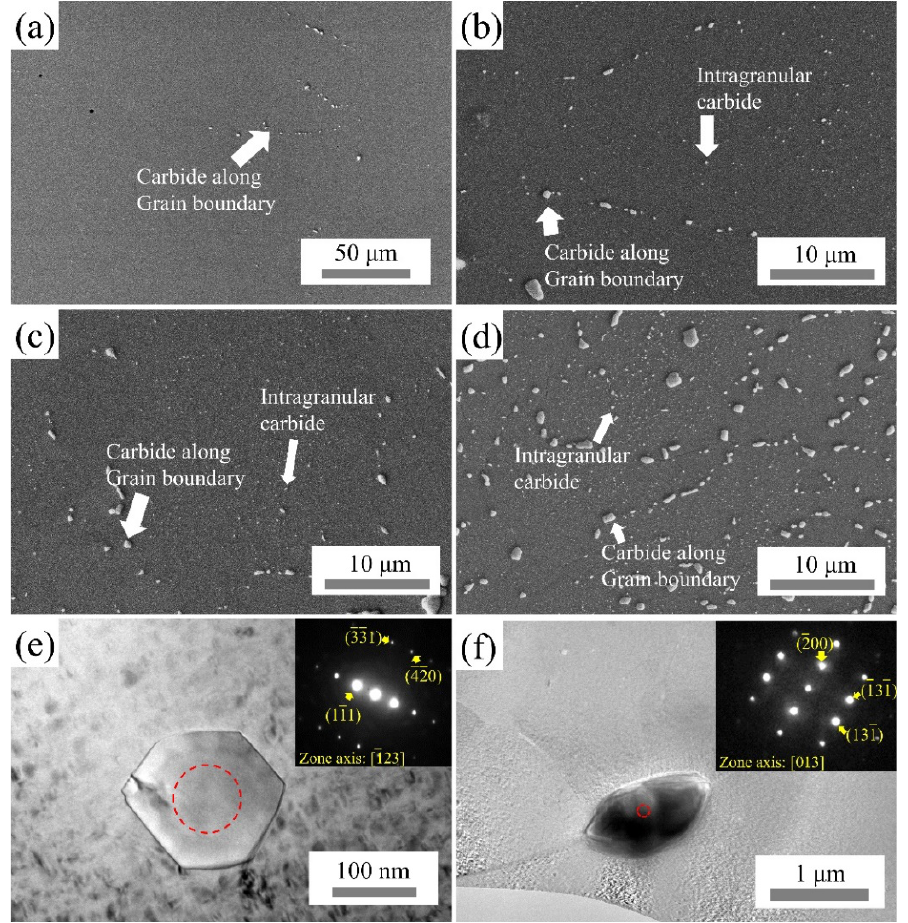
Figure 5. Microstructure of specimens after STA. ( a ) Without NbC, ( b ) 0.5% NbC, ( c ) 1.0% NbC, and ( d ) 5.0% NbC. ( e ) TEM bright field image of the specimen without NbC; diffraction pattern of carbide particle. ( f ) TEM bright field image of the specimen with 0.5% NbC; diffraction pattern of carbide particle. Table 3. TEM-EDS analysis of particles along cellular wall after post-SLM heat treatments (at%). Treatment